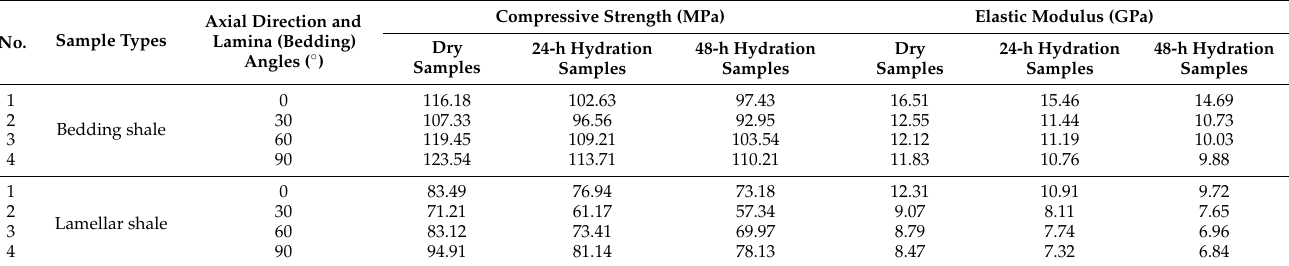
Table 2. Uniaxial compression test